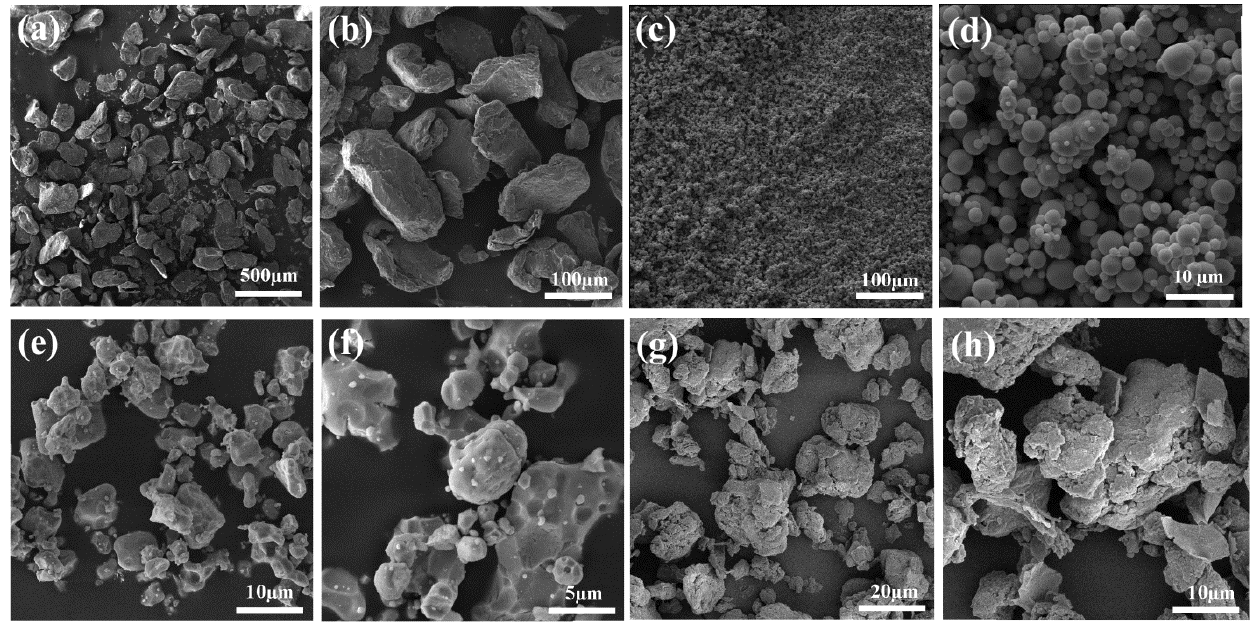
Figure 3. SEM micrographs of ( a , b ) Mg, ( c , d ) Zn, ( e , f ) Zr and ( g , h ) MZ